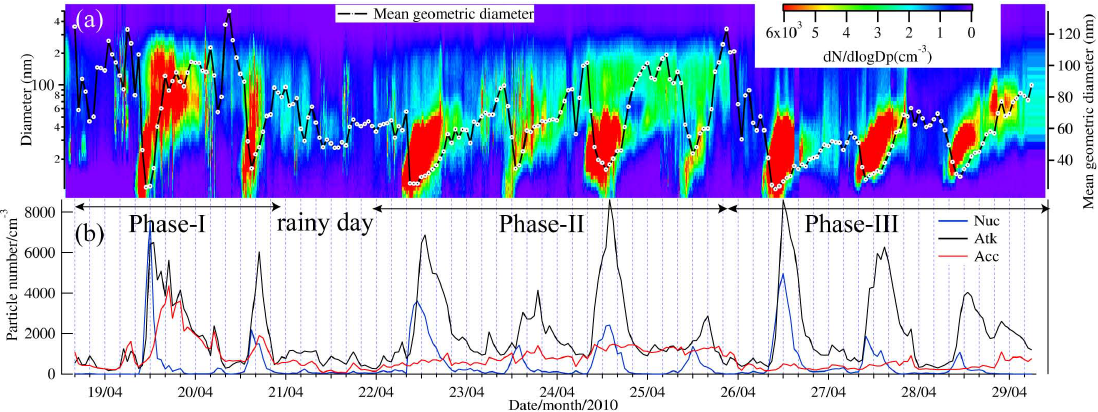
Fig. 7. (a) Diurnal evolution of particle number and size distribution at the summit of Mt. Tai during 19–28 April, 2010. The black line represents the changes of geometric mean diameter of aerosol particles following the time. (b) Particle number concentrations of nucleation mode (Nuc, diameter 10–20nm), Aitken mode (Atk, diameter 20–100nm), and accumulation mode (Acc, diameter